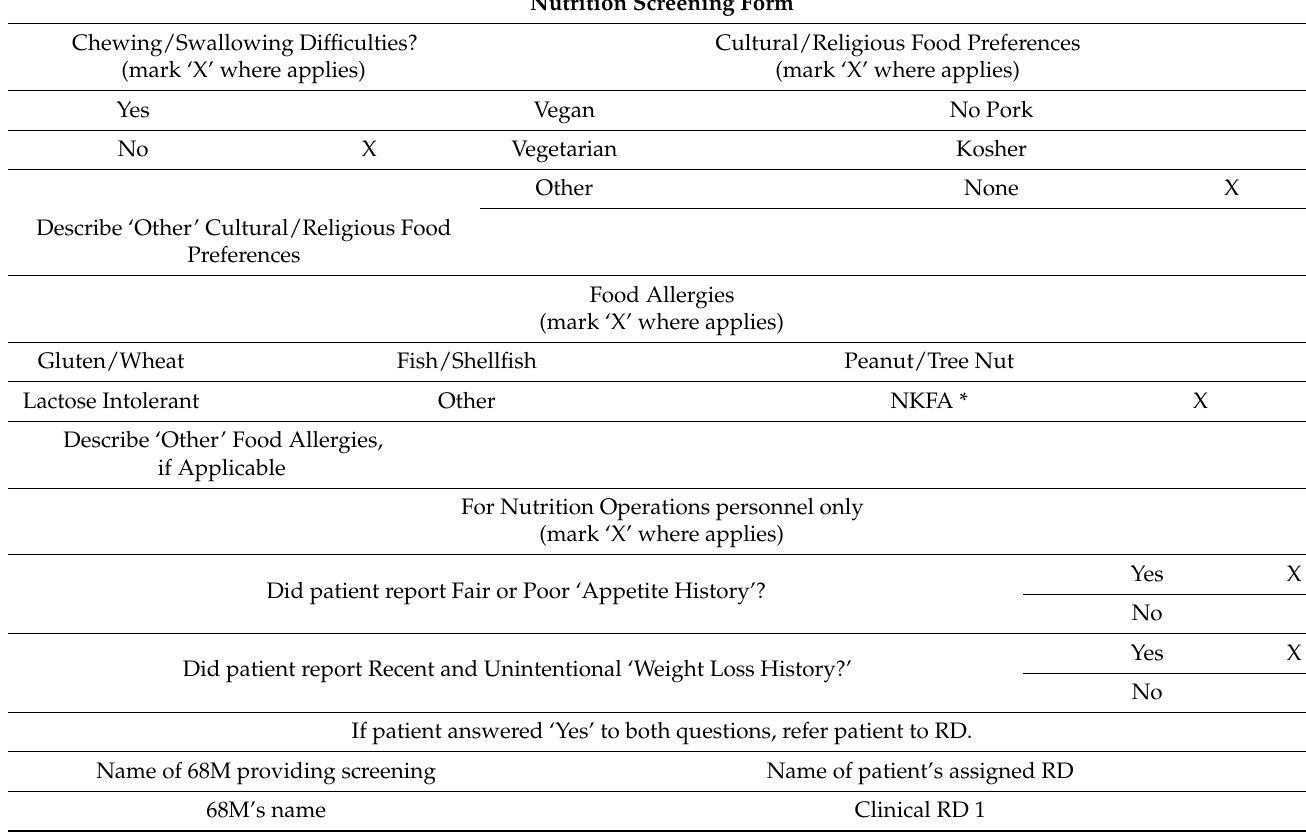
Table 4. Cont. Nutrition Screening